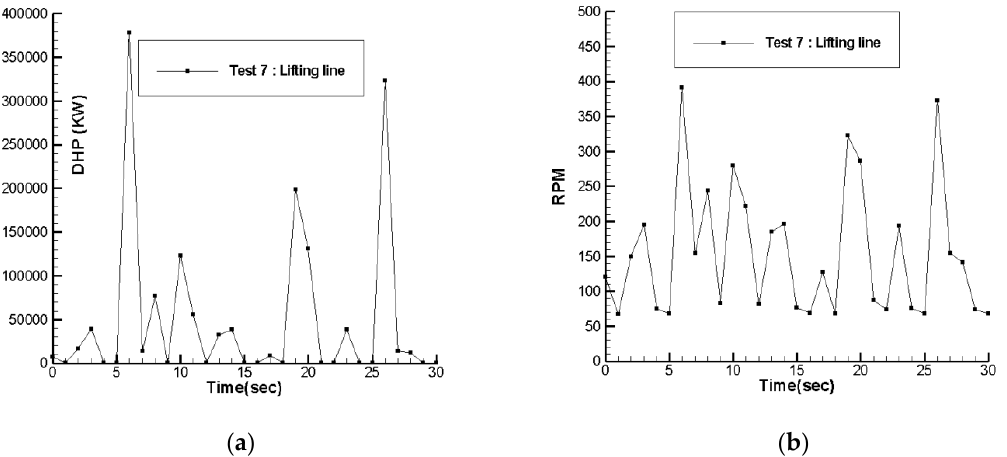
Figure 34. Time history of the required DHP ( a ) and RPM ( b ), numerical experiment #7.